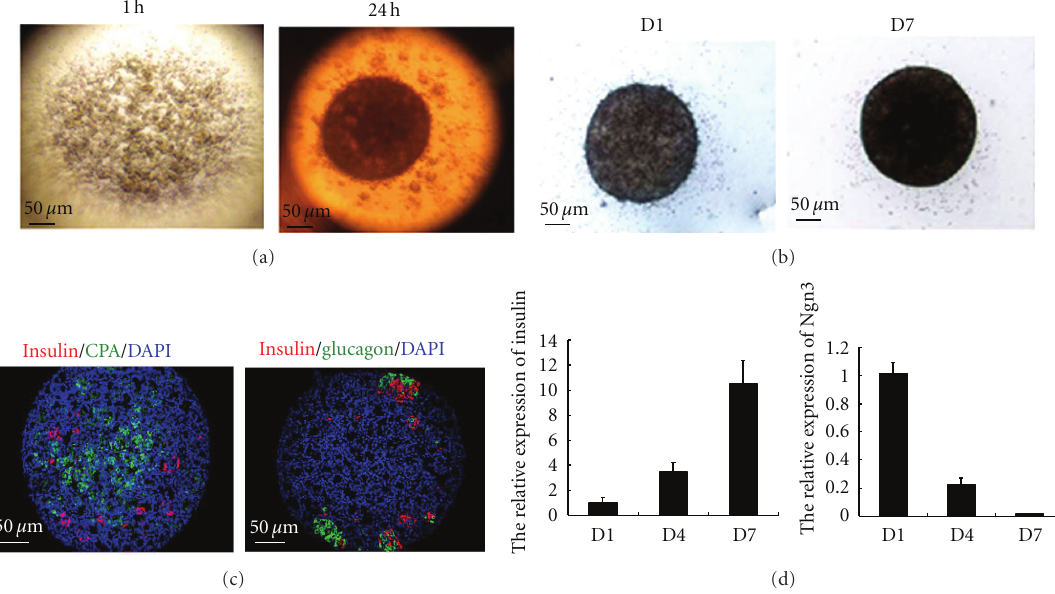
Figure 4: The characteristics of our new culture system. (a) The photo of pancreatic cells cultured in inverted dish for 1h and 24 h. (b) The morphology of spheres cultured for 1 and 7 days at the air-medium interface. (c) Immunohistological analysis of insulin, glucagon, and CPA staining in spheres cultured for 7 days. (d) The expressional dynamics of Ngn3 and insulin mRNA in spheres cultured for 1, 4, 7